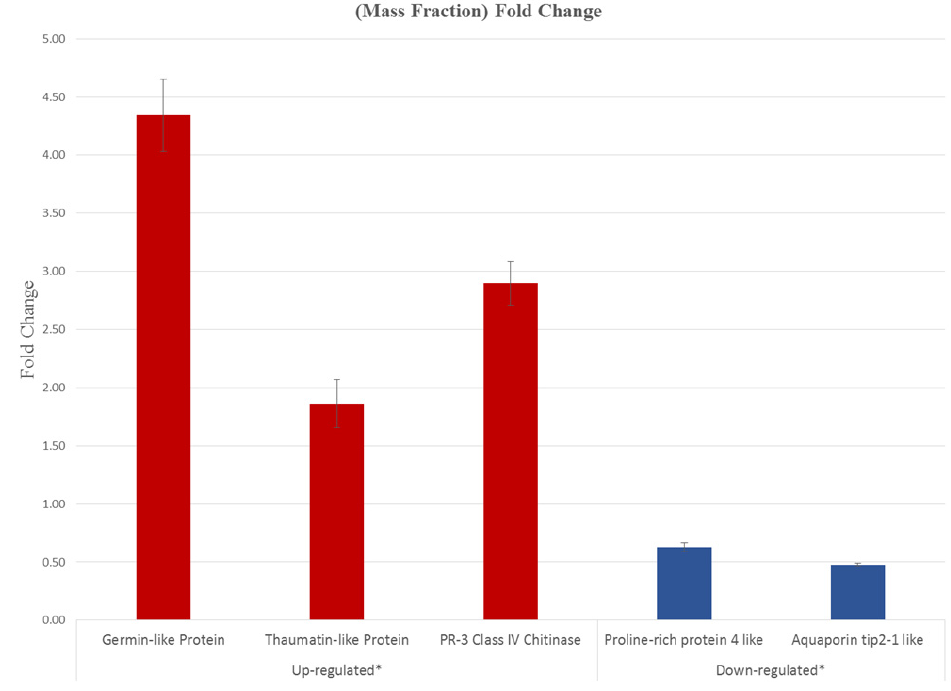
Figure 7. Validation of five differentially expressed genes through qRT-PCR. The fold change is statistically significant. Red, upregulated genes; blue, downregulated genes, according to RNA-seq analyzed data. The standard deviation is indicated with